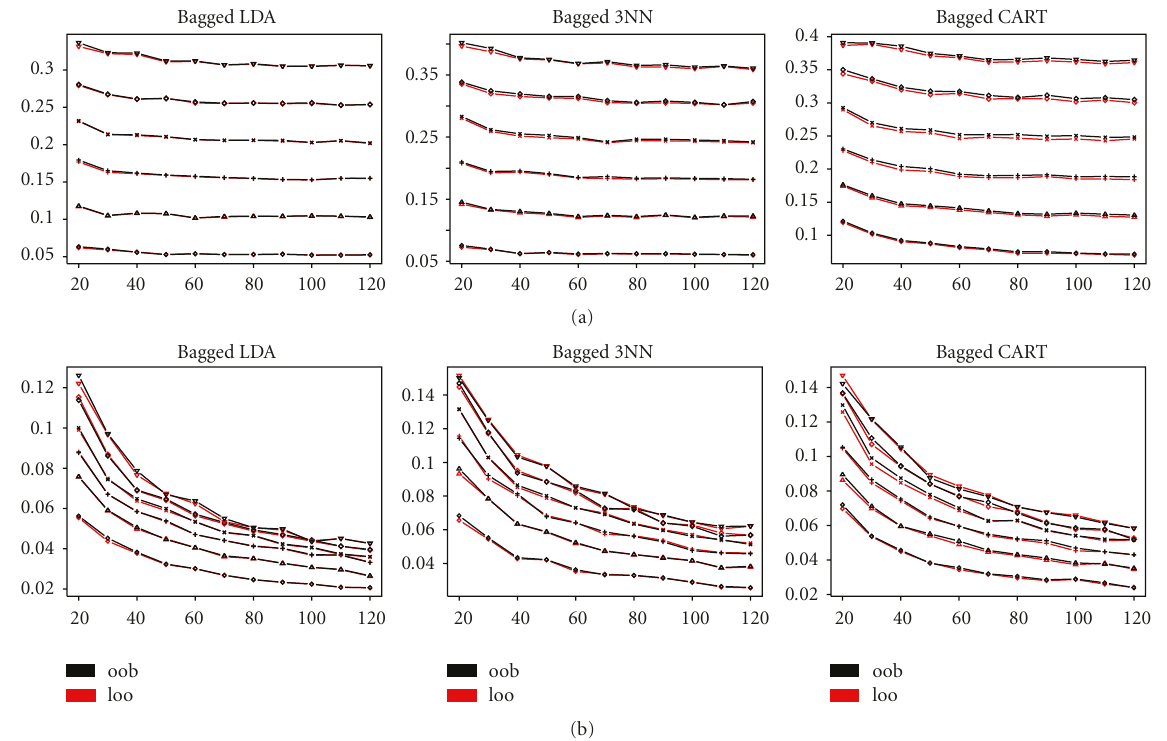
Figure 1: Comparison of out-of-bag and leave-one-out for di ff erent Gaussian models over the number of samples, for dimensionality p = 2. (a) Sample mean. (b) Sample standard